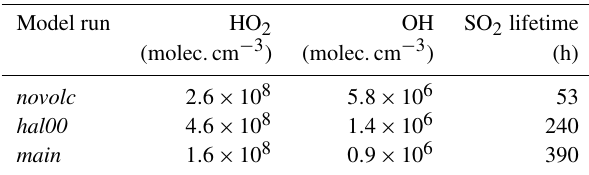
Table 3. In-plume concentrations of HO 2 and OH and instantaneous lifetime of SO 2 with respect to oxidation by OH for parts of the plume aged 30 ± 5 min at 08:00UTC on 1 August 2012 for three model runs. Figures for the novolc use the same grid cell weighting as the main model